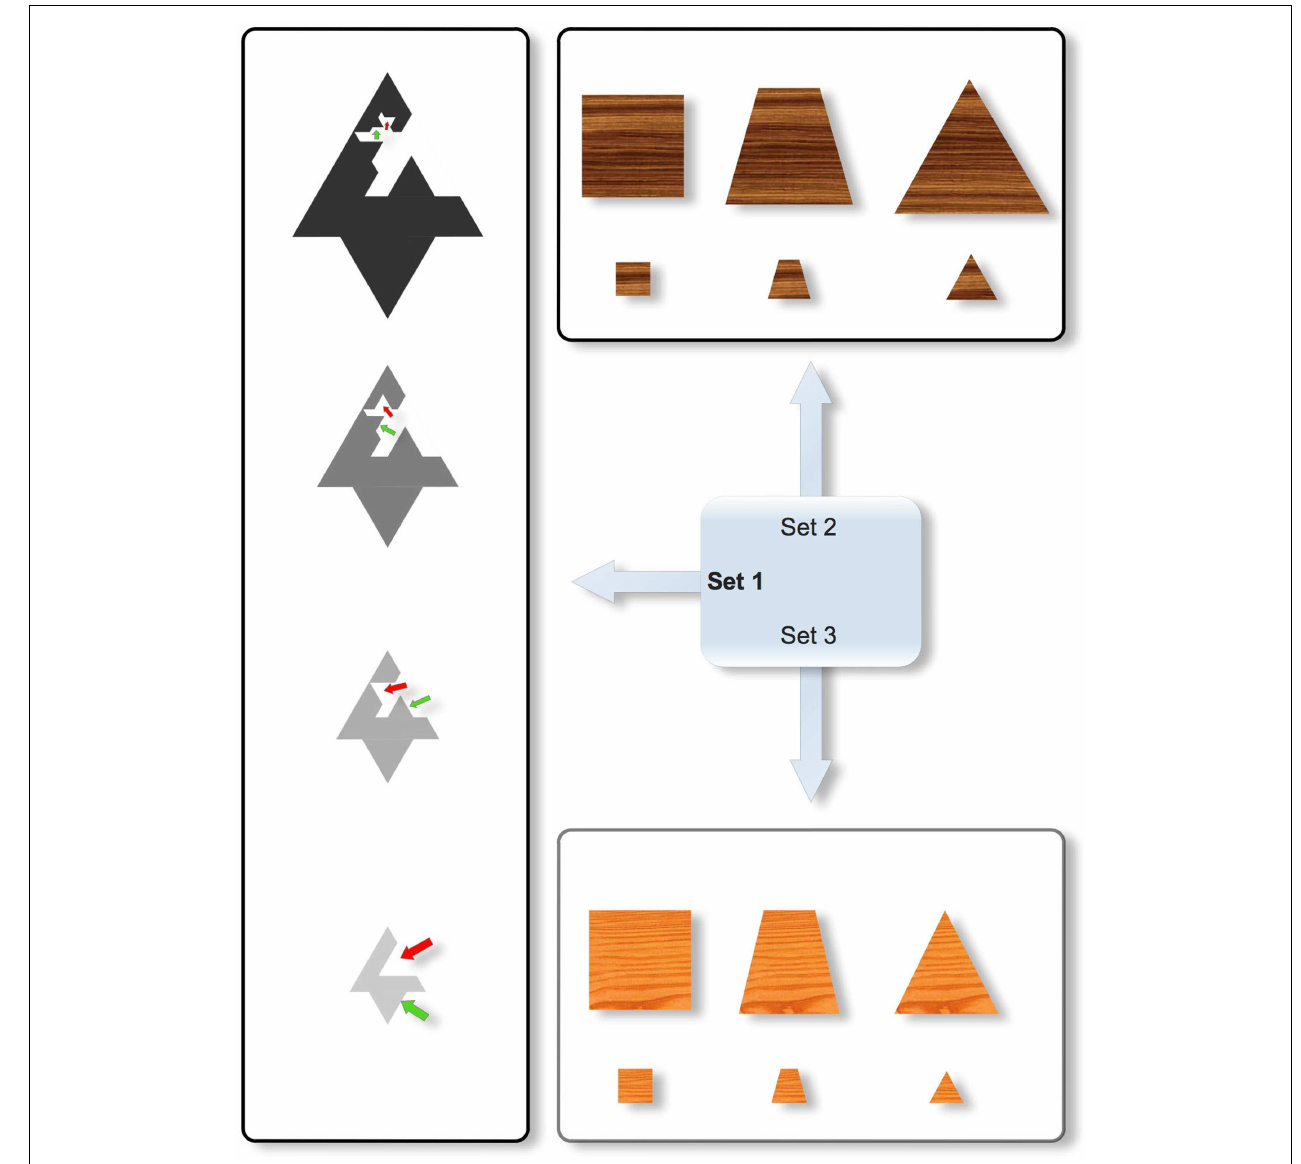
shape from left to right by keeping the area constant, but in that case, the convex envelope surrounding the object increases from left to right so that the perceived size might vary according to changes in shapes. As a result, the top left square might seem more similar to the bottom right triangle than the top right triangle in comparison to the bottom left square (whereas the ratios of the areas for the two respective pairs are equal). In Set 3 (Bottom), the shapes vary from left to right while keeping the height and the base constant. As a result, the top left square might seem further from the bottom right triangle than the top right triangle in comparison to the bottom left square (because the ratios of the areas for the two respective pairs are unequal).